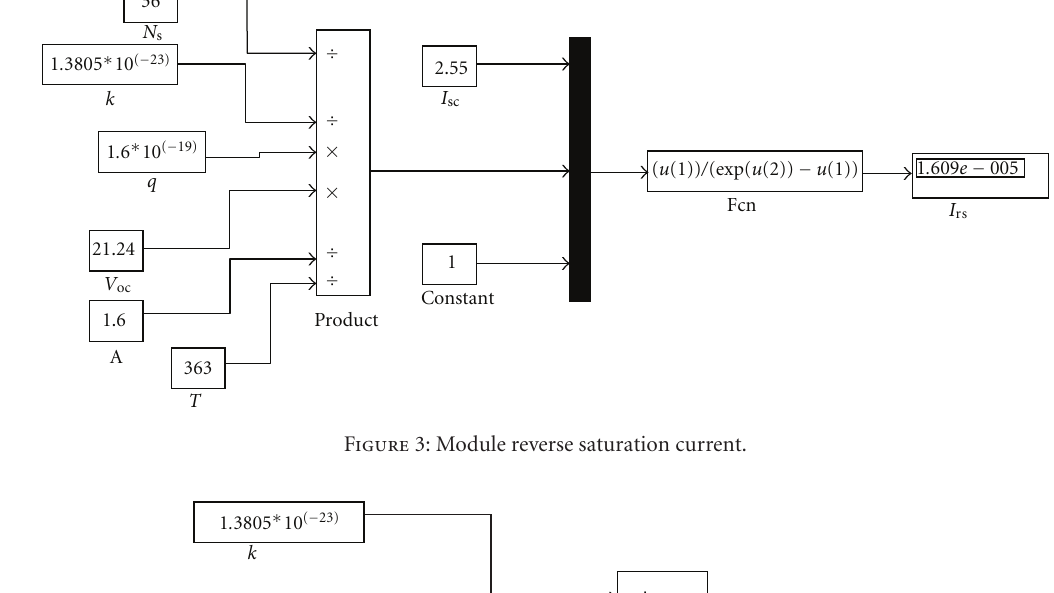
Figure 3: Module reverse saturation current.